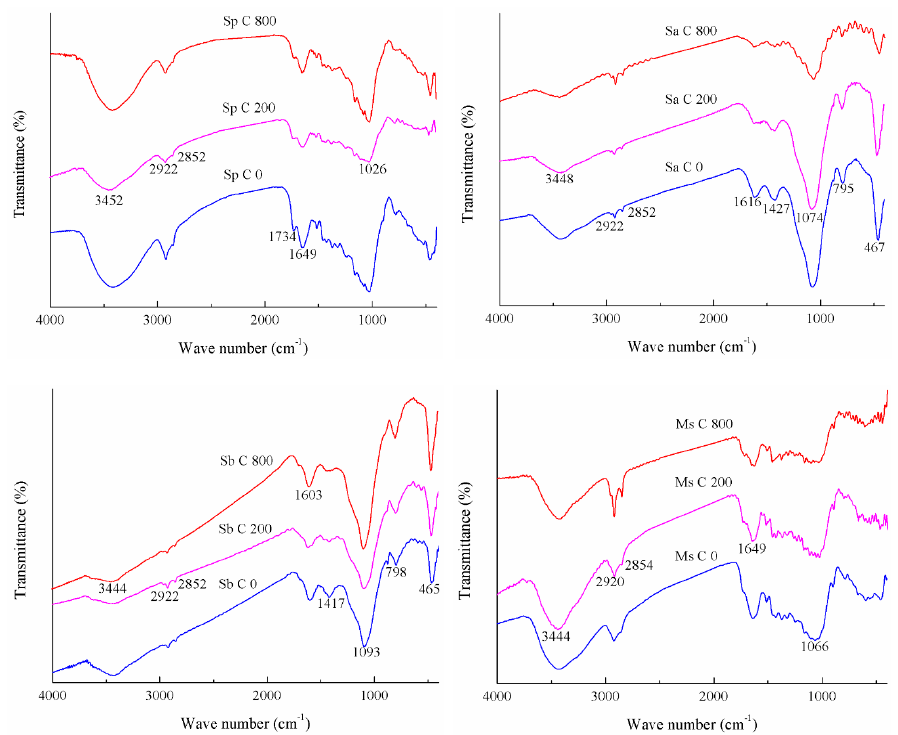
Figure 2. FTIR spectra of Cd(II) adsorbed by the four biosorbents under different initial Cd(II) concentrations. Note: the specific experiment conditions are as follows: the initial Cd(II) concentrations are set to 0, 200 and 800 mg / L, respectively, the ionic strength (NaCl) is 0.2 mol / L, and the initial pH value is not adjusted. The adsorption of Cd(II) on the rice straw powder (Sp), rice straw ash (Sa), rice straw biochar (Sb), and modified rice straw (Ms) at initial Cd(II) concentrations (C) 0, 200, and 800 mg / L are represented by Sp C 0, 200, 800, Sa C 0, 200, 800, Sb C 0, 200, 800, and Ms C 0, 200, 800,